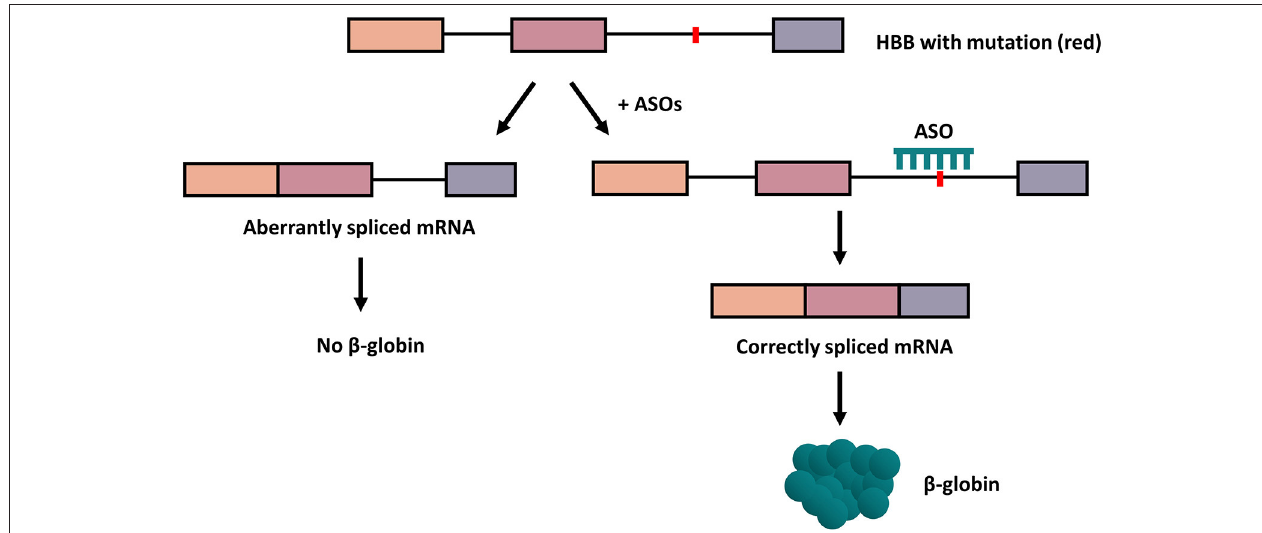
FIGURE 2 | How ASOs work to correct the aberrant splicing. In the presence of ASOs targeted at the mutation on the gene, the correction of aberrant splicing of human β -globin occurs and leads to the production of functional β -globin protein. Boxes indicate exons; lines, introns; red dots, mutation.